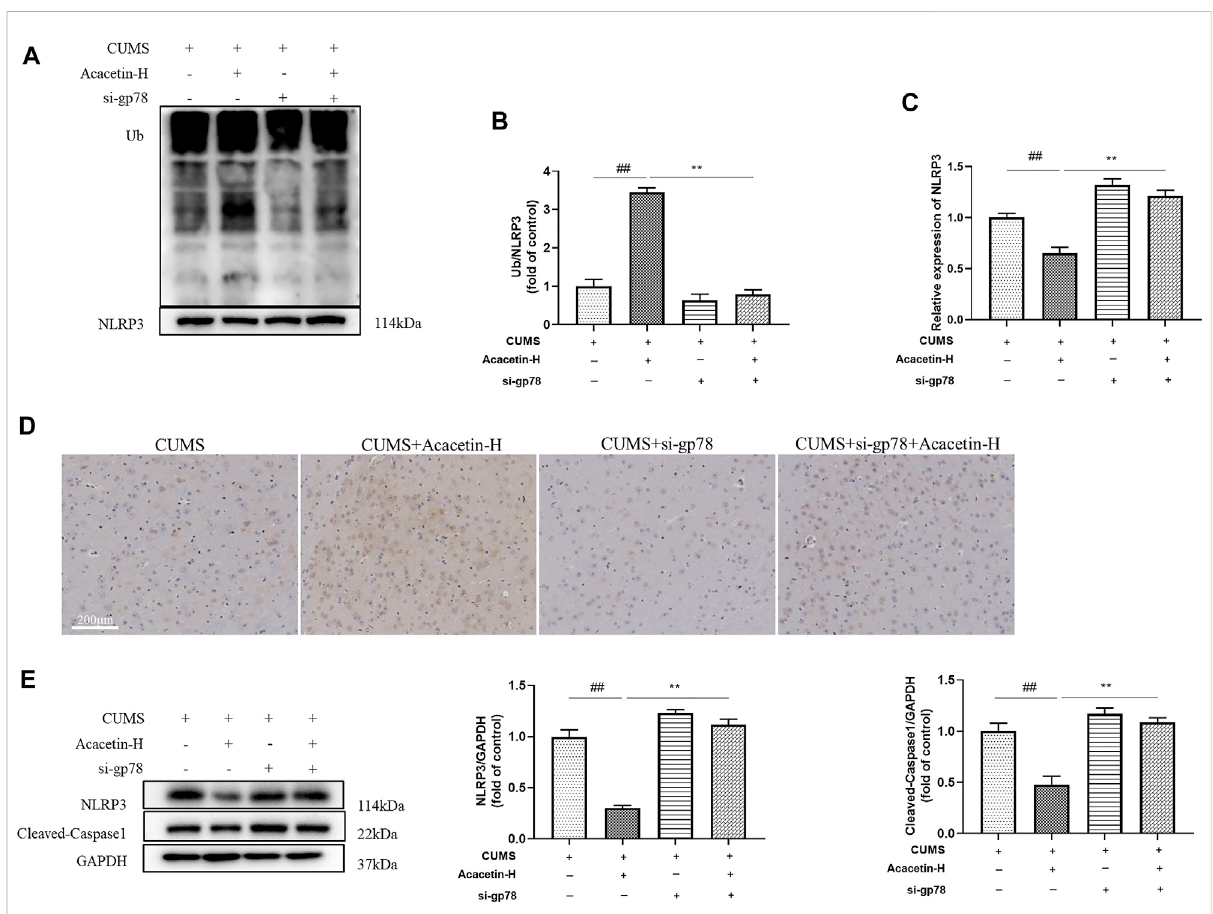
FIGURE 7 In fl uenceofgp78siRNAs onhippocampalNLRP3in fl ammasomeinCUMSmice. (A – B) NLRP3ubiquitinationlevels inthehippocampusofmice weredeterminedbyco-ip. (C – D) HippocampalNLRP3expressionlevelsoftheexperimentalgroupsweredetectedwiththeimmunohistochemistry. (E) Protein expression of NLRP3 and Cleaved-Caspase1 in the western blotting. Results are expressed as the mean ± SEM ( n = 3 per